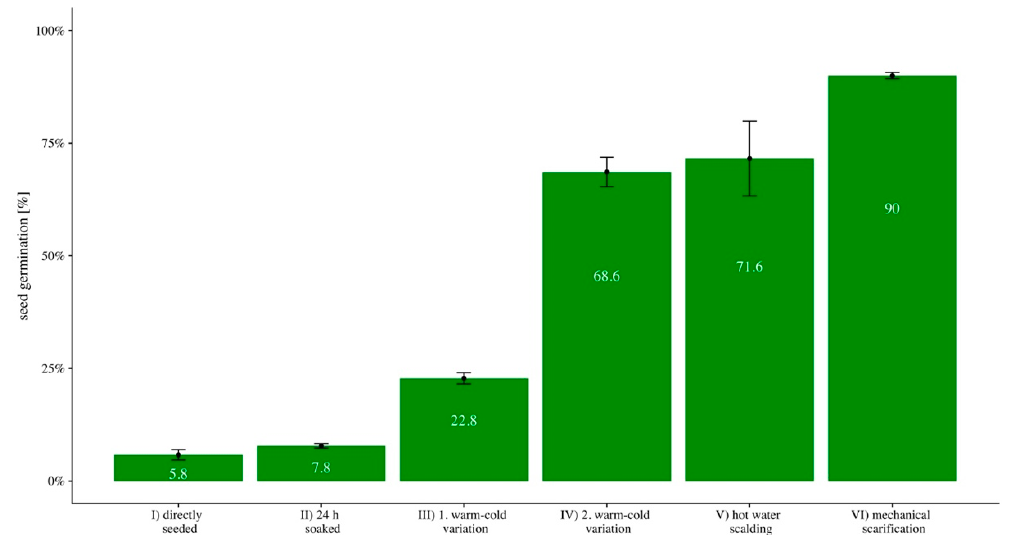
Figure 4. Black locust seed germination (%) by (I) directly sowing, (II) 24 h soaking, (III) warm-cold treatment for two hours at 45 °C and two hours at − 20 °C, (IV) warm-cold treatment of two hours at 60 °C and two hours at − 20 °C, (V) hot water scalding, and (VI) mechanical scarification. The error bars show the standard error of the mean per seed treatment. Database = 3000 seeds. Table 2. Pairwise t -tests of the black locust seed germination by (I) directly sowing, (II) 24 h soaking, (III) warm-cold treatment for two hours at 45 °C and two hours at − 20 °C, (IV) warm-cold treatment of two hours at 60 °C and two hours at − 20 °C, (V) hot water scalding, and (VI) mechanical scarification.